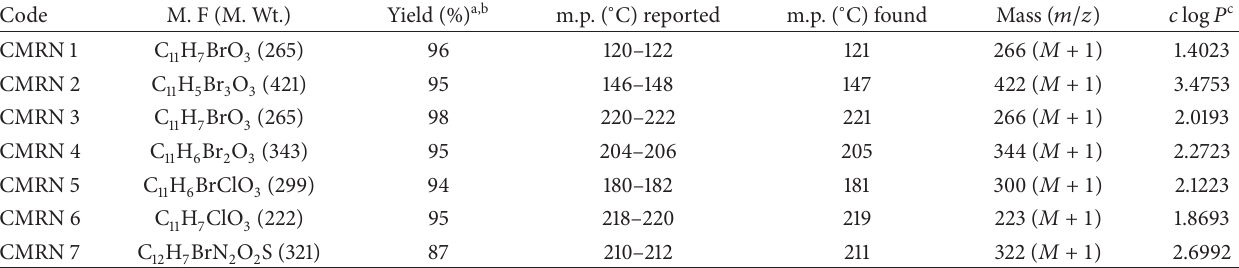
Table 1: Physicochemical characteristics of 3-mono/dibromoacetyl-6-halogenated coumarin analogues CMRN 1–CMRN 7. Code